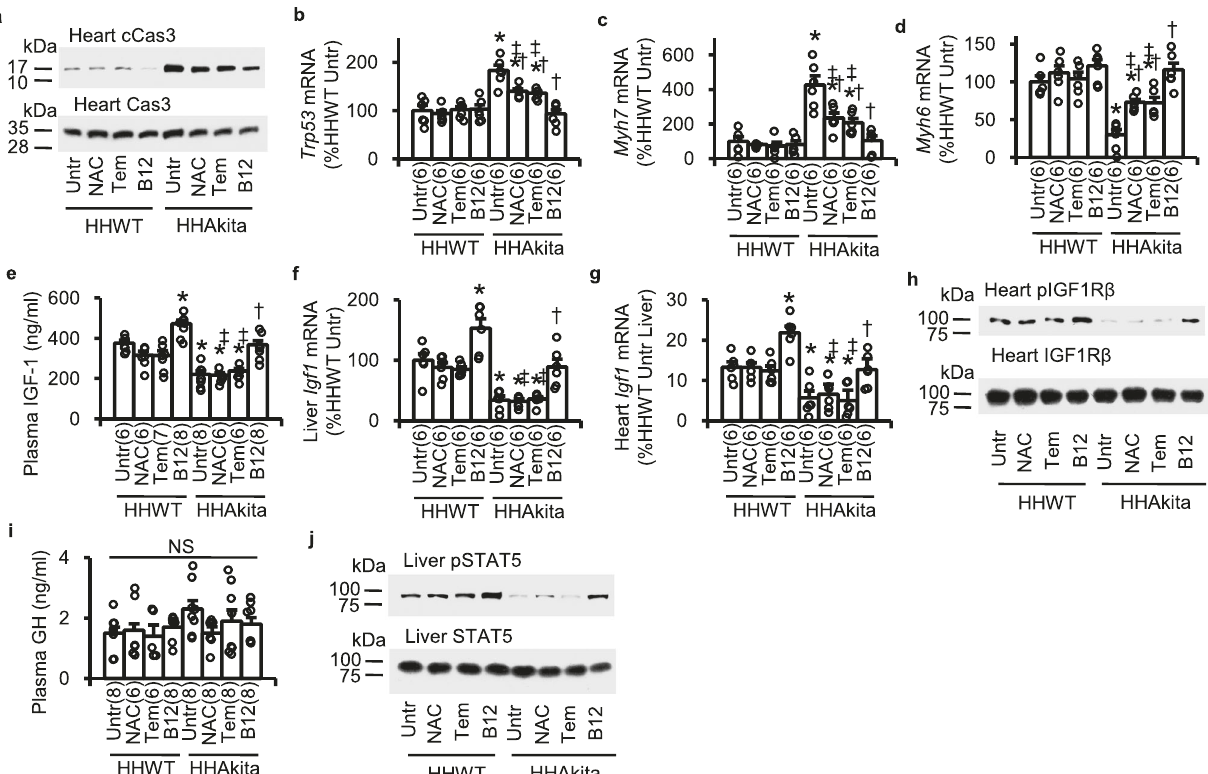
Fig. 5 Effects of orally administered NAC, tempol (Tem), and B12 on the expression of apoptosis- and cardiomyopathy-associated genes and the parameters related to insulin-like growth factor (IGF)-1 signaling. a Immunoblots for cardiac cleaved caspase 3 (cCas3) and total caspase 3 (Cas3). b Cardiac mRNA levels of the tumor repressor protein 53 gene ( Trp53) . c Cardiac mRNA levels of the β -myosin heavy chain gene ( Myh7) . d Cardiac mRNA levels of the α -myosin heavy chain gene ( Myh6) . e Plasma IGF-1 levels. f Hepatic Igf1 mRNA levels. g Cardiac Igf1 mRNA levels. h Immunoblots for cardiac levels of phosphorylated IGF-1 receptor β (pIGF1R β ) and total IGF1R β . i Plasma levels of growth hormone (GH). j Immunoblots for hepatic phosphorylated pSTAT5 and total STAT5. HHWT, Elmo1 H/H Ins2 + / + ; HHAkita, Elmo1 H/H Ins2 Akita/ + . Data are expressed as means ± standard errors. The number of animals analyzed is given in the parentheses in each fi gure. mRNA levels normalized by β -actin mRNA are expressed relative to the mean levels in unteated HHWT mice as 100%. * P < 0.05 vs. untreated (Untr) HHWT mice by Tukey – Kramer Honestly Signi fi cant Differences test after one-way ANOVA; † P < 0.05 vs. untreated HHAkita mice; ‡ P < 0.05 vs. B12-treated HHAkita mice; NS, not signi fi